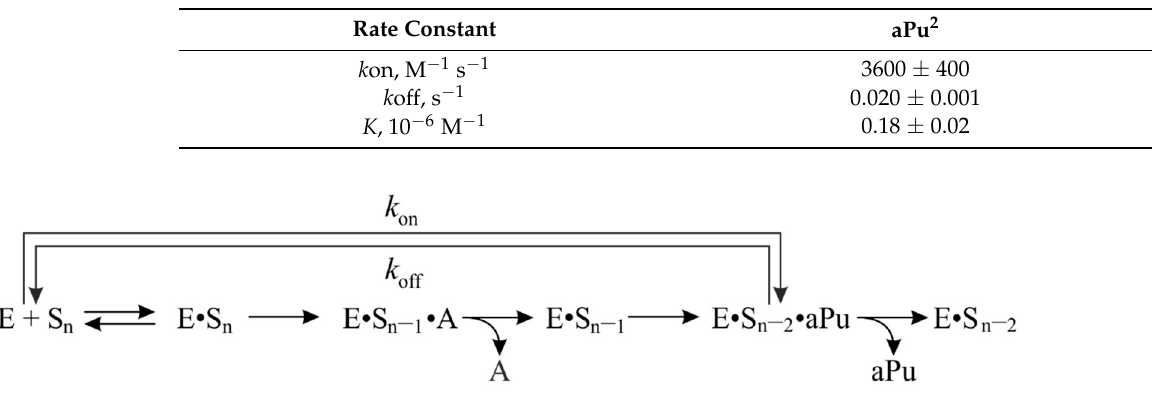
Figure 7. The ratio of the initial DNA substrate to products during the interaction between Nfo and FAM Exo in the presence of 2  ‐ deoxyguanosine monophosphate ( a ). Amounts of 16 ‐ and 15 ‐ mer products in the reaction mixture as a function of dGMP concentration ( b ). [Nfo] = 1.0 μ M and [FAM Exo ] = 1.0 μ M; [dGMP] varied from 0 to 300 mM. To quantitatively describe this process, curves were constructed for changes in aPu fluorescence intensity using the stopped ‐ flow method; these curves characterize the in ‐ teraction between Nfo and aPu 1T in the presence of either 2  ‐ deoxyguanidine mono ‐ phosphate or thymidine monophosphate at various concentrations (Figure 8a,b). It was demonstrated that, at a higher concentration of 2  ‐ deoxynucleoside monophosphates,